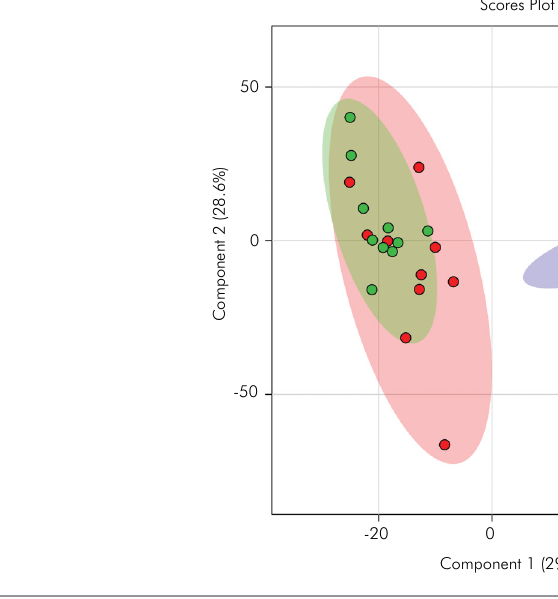
Figure 2. Two-component Principal Component Analysis model showing sample clustering of saliva without any medicine (black) and after treatment with antihistamine syrup in vitro (blue) and in vivo (green). In vitro treatment with the antihistamine pill extract is shown in red. The percentage of variance captures by 36.38% and Principal Component 2 (PC2) was